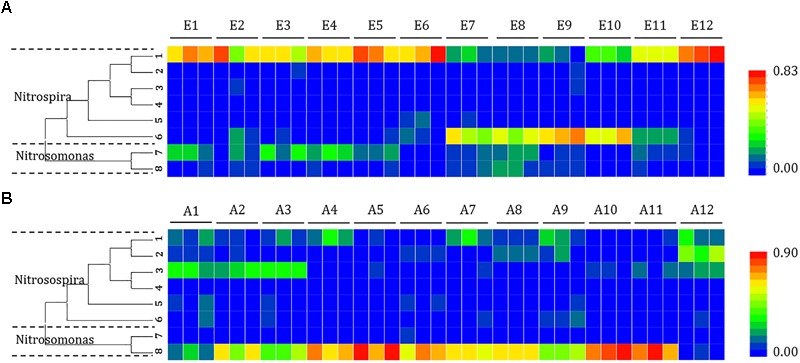
Heat map showing the relatedness of ammonia-oxidizing bacteria community structures in the analysis of the (A) mudflat and (B) agricultural sites based on the relative abundance of distinct lineages of ammonia-oxidizing bacteria 16S rRNA genes analyzed using pyrosequencing. The relative abundance of each lineage in each soil is displayed as a heat map representation. The phylogenetic position of each representative operational taxonomic unit is shown in the phylogenetic tree on the left-hand side.